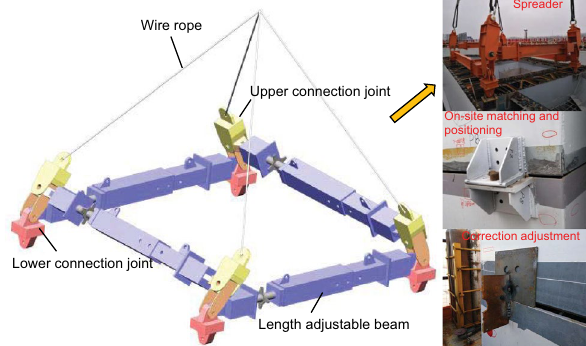
Figure 16. Steel shell segment hoisting and precise